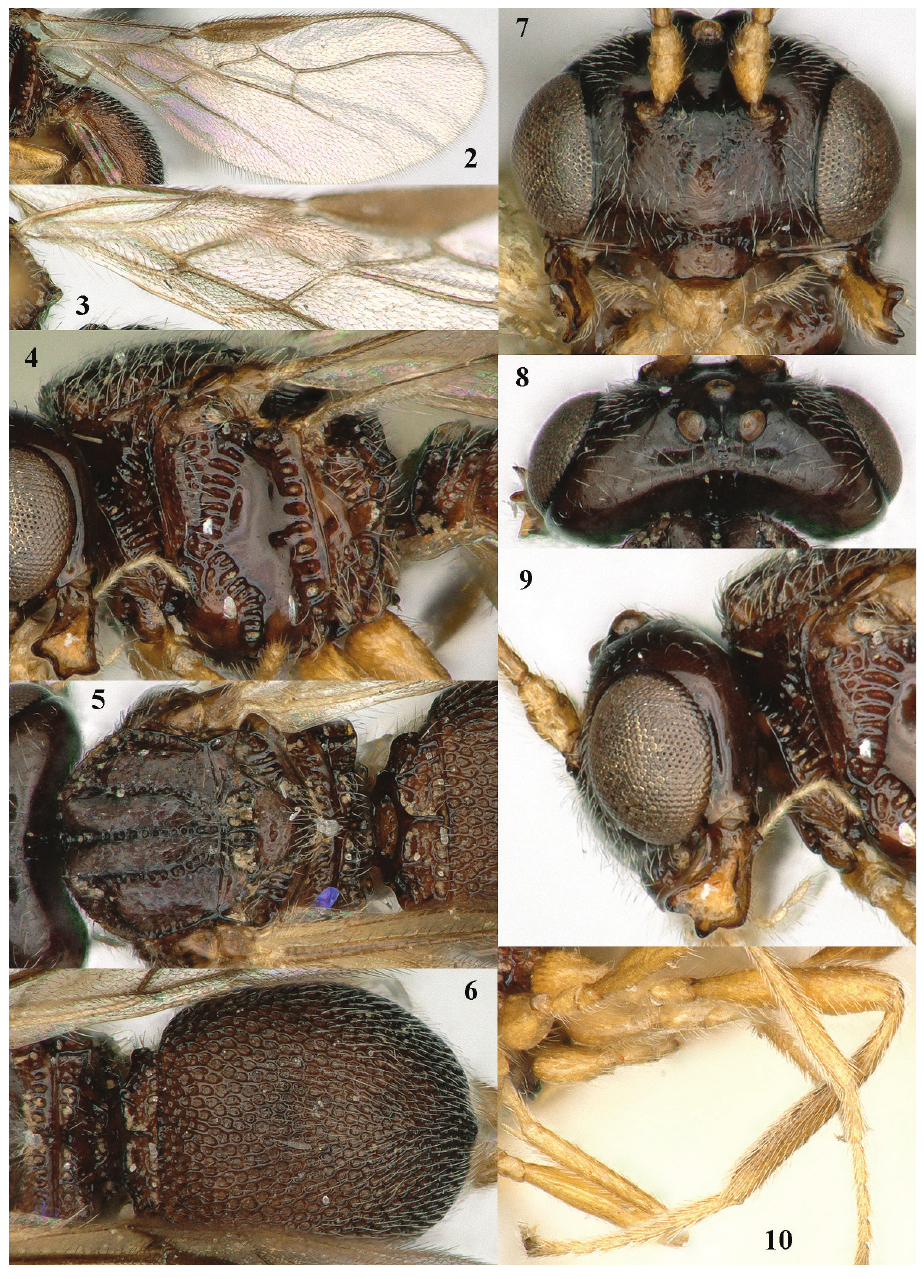
Figures 2–10. Gastralysia garambana Fischer, ♀ , Ivory Coast. 2 fore wing 3 hind wing 4 mesosoma lat- eral aspect 5 mesosoma dorsal aspect 6 first–third metasomal tergites dorsal aspect 7 head anterior aspect 8 head dorsal aspect 9 head lateral aspect 10 hind leg